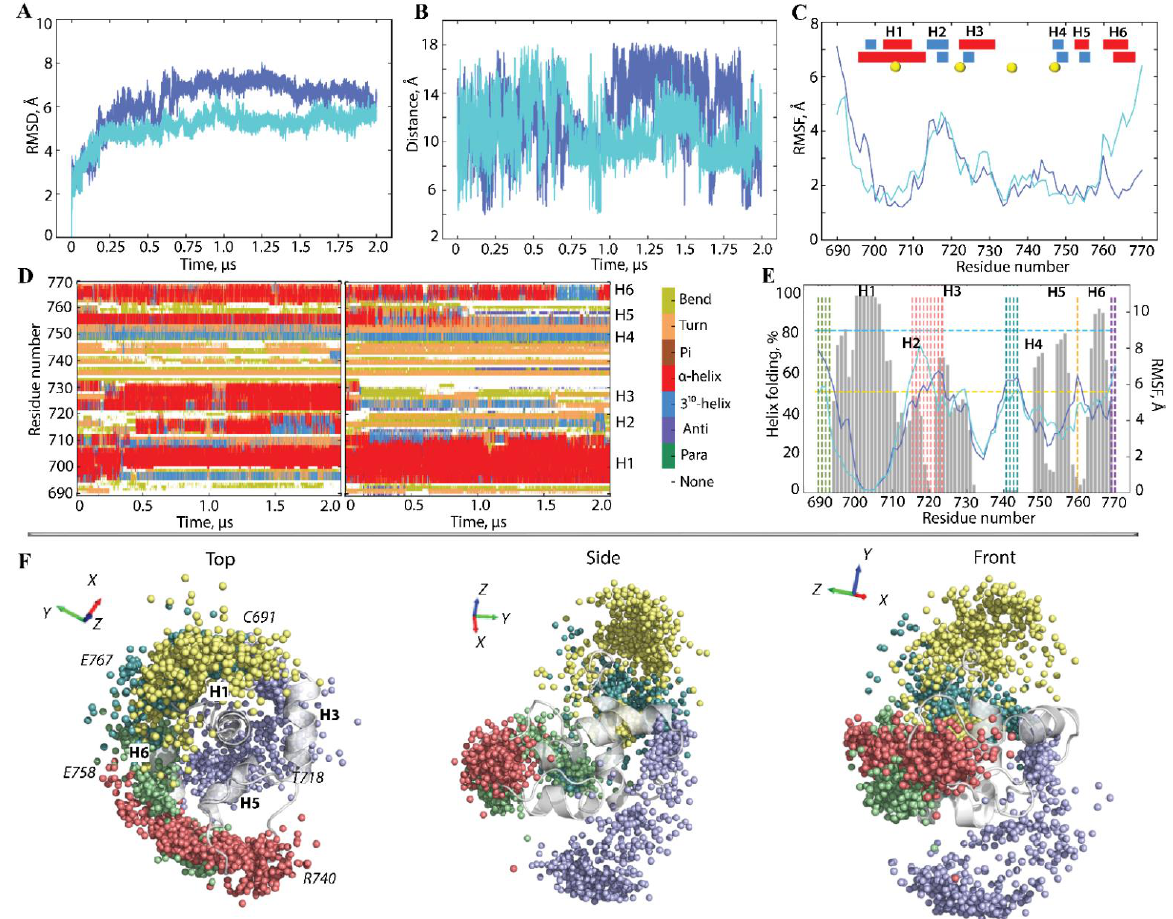
Figure 2. Conventional MD simulations of KID GC . ( A ) RMSDs, computed on the Cα atoms after fitting on initial conformation (at t = 0 ns), ( B ) distances between the Cα -atoms from F689 and D768 residues, and ( C ) RMSFs computed on the Cα atoms after fitting on initial conformation (at t = 0 ns). In ( C ), the insert shows the interpretation of the folded secondary structures, αH - (red) and 3 10 -helices (blue), labelled as H1-H6, assigned for a mean conformation of each MD trajectory. Yellow balls